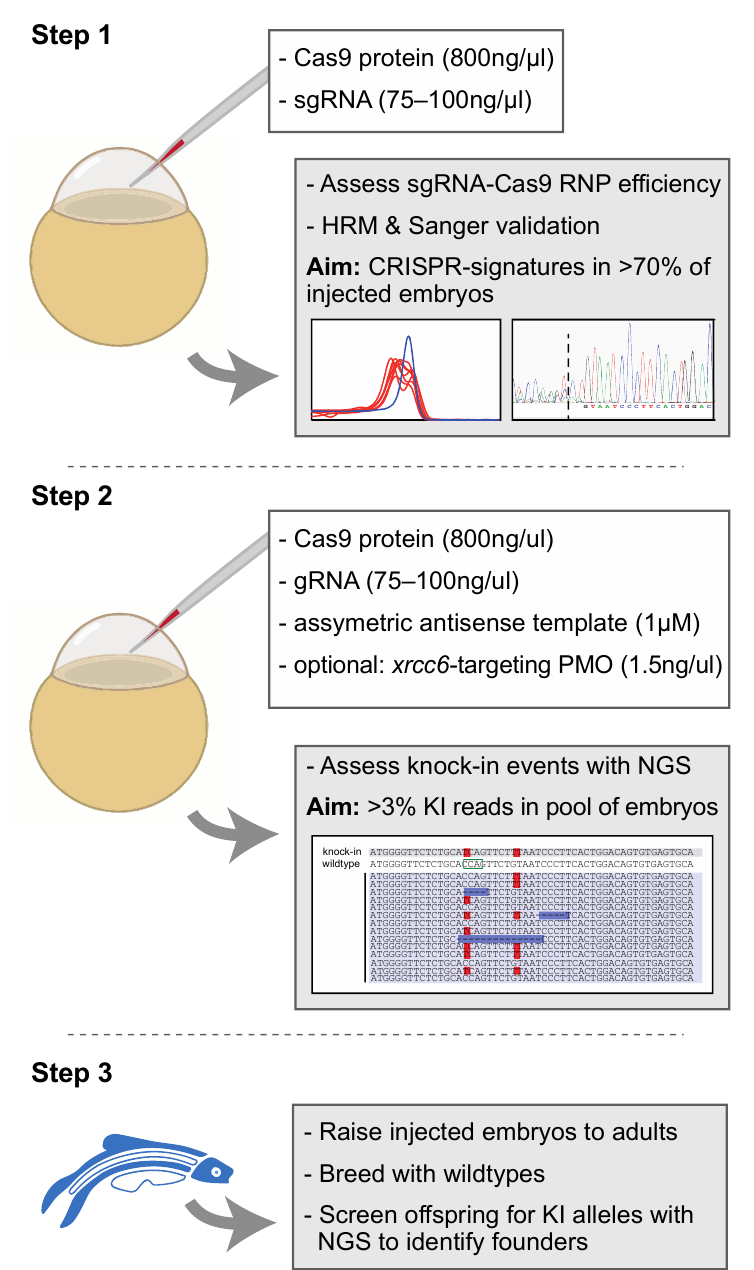
Figure 4. Proposed strategy for the efficient generation of knock-in zebrafish. Step 1 entails the verification of sgRNA-Cas9 efficiency at creating genomic lesions using high resolution melting (HRM) analysis. Step 2 concerns the injection of sgRNA-Cas9 ribonucleoprotein complexes and the asymmetric antisense oligonucleotide template with the variant of interest. Next generation sequencing (NGS) is recommended to determine knock-in efficiency. In the situation of low knock-in efficiency, knockdown of non-homologous end-joining protein Ku70 (by co-delivery of an morpholino antisense oligonucleotide (PMO), targeting xrcc6 ) may offer a means to improve knock-in efficiency. Finally, injected embryos with sufficient knock-in reads can be raised to adults and screened for founders with the variant of interest in the germline (step 3). The white boxes in step 1 and step 2 described the key components injected into the zebrafish zygote. A detailed protocol can be found in Supplemental Document S1.